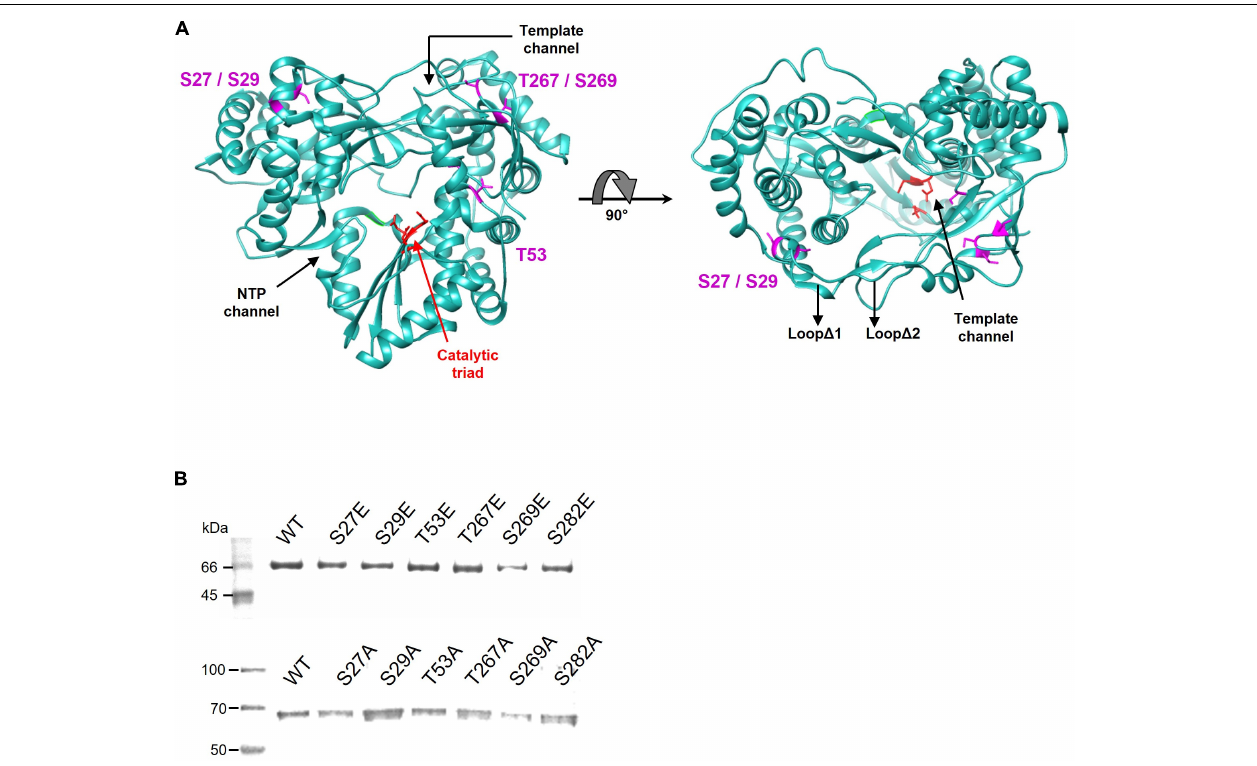
FIGURE 3 | (A) Localization of the residues phosphorylated by Akt. The positions of the amino acids identified by proteomics are shown in magenta on the structure of the NS5B HC-J4 (PDB: 1NB4) protein. The amino acids of the catalytic triad are shown in red. The most important structural elements (template channel, nucleotide entry channel and loops (cid:49) 1 and (cid:49) 2) are also indicated. (B) SDS-PAGE gel showing purified WT and Glu (upper panel) or Ala (lower panel) mutant proteins for each position. The molecular weight marker is shown on the left. The identity of the protein in each lane is indicated above the protein